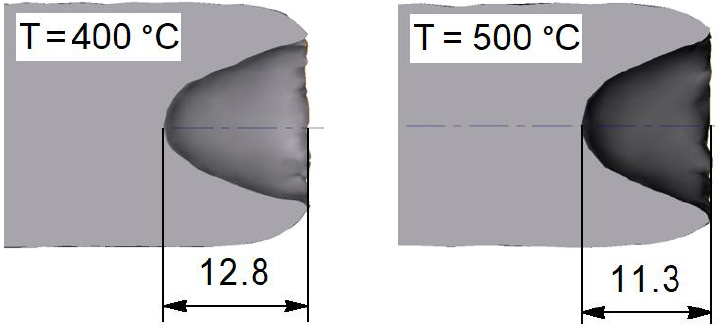
Figure 8. The depth of end-tightening of bars after RSR for different temperatures.